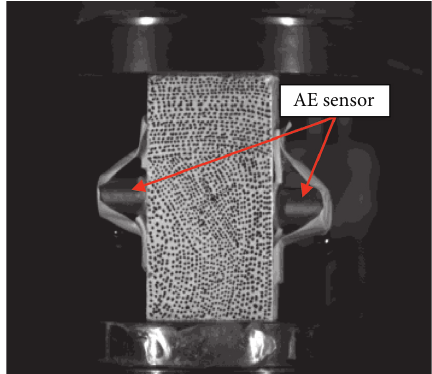
Figure 3: The layout of loading and AE sensors.